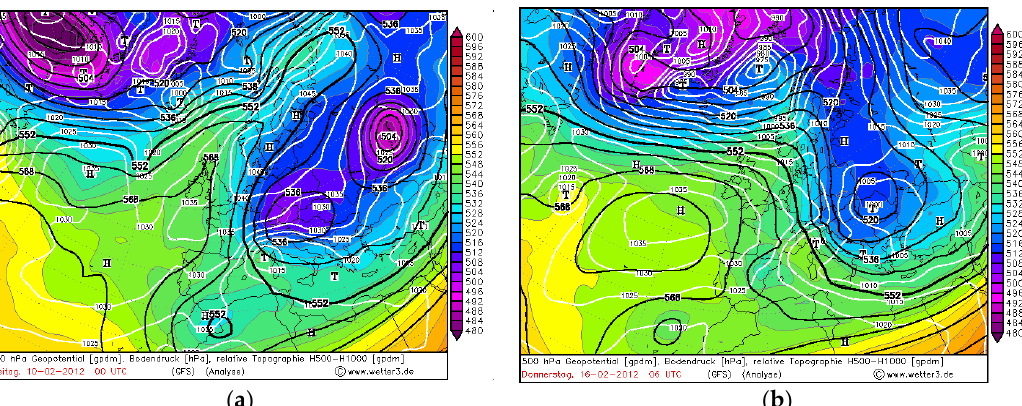
Figure 8. Weather maps for 10th February ( a ) and 16th February ( b ) 2012. The maps show the 500 hPa geopotential (black contours), sea-level pressure (white contours) and relative topography H500–H1000 (color scale) [15].